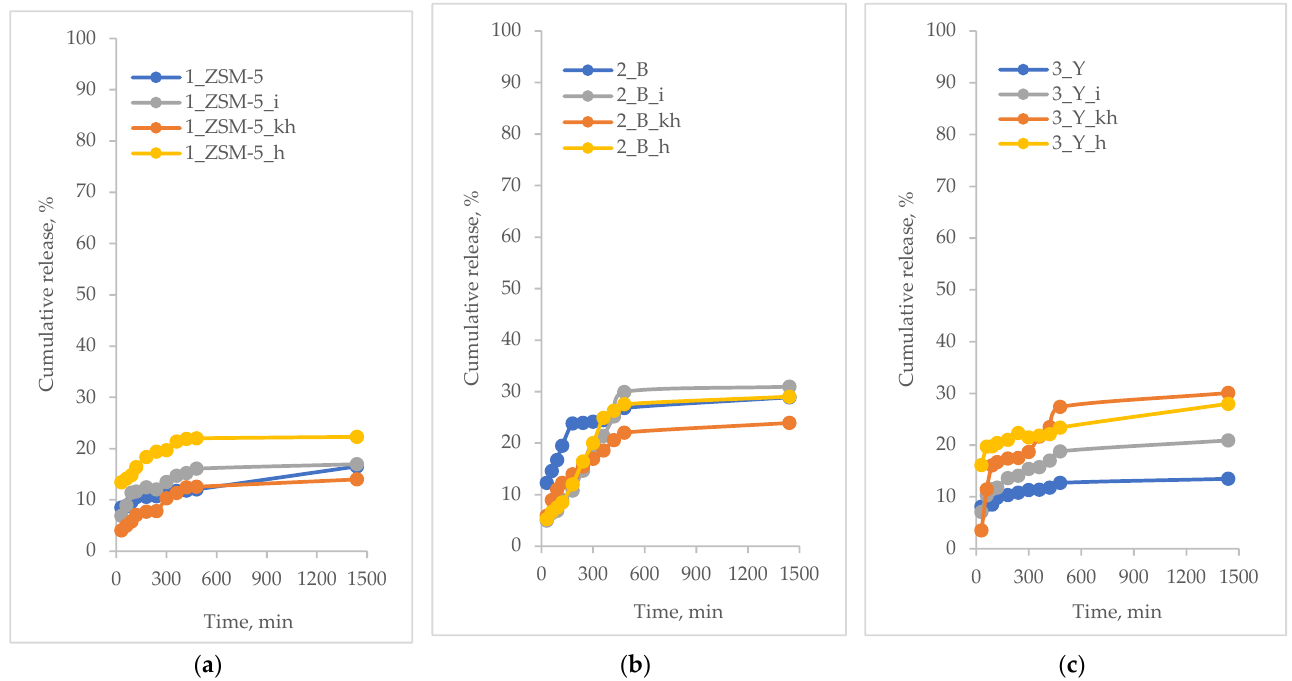
Figure 7. Percentage of ferulic acid released from modified hierarchical zeolites into acceptor fluid with ethanol; ( a ) samples based on ZSM-5 zeolite; ( b ) samples based on BEA zeolite; ( c ) samples based on FAU zeolite.